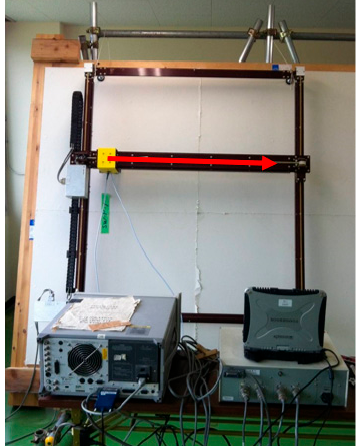
Figure 3. Developed polarimetric GB-SAR system. The line with an arrow indicates the position of the 1D survey line in Figure 1a. Table 1. Measurement parameters of the GB-SAR system.